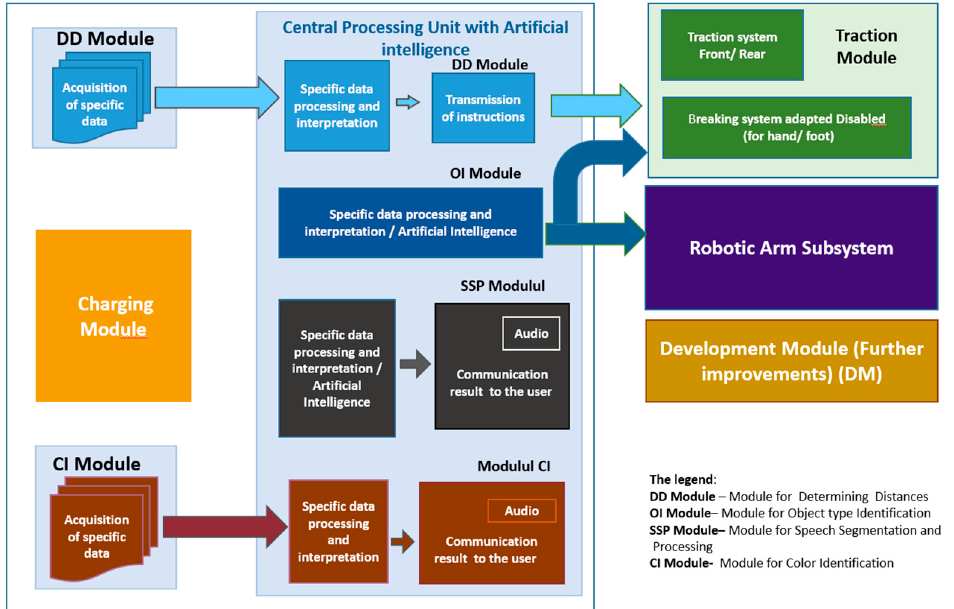
Figure 2. Diagram of device for visually impaired